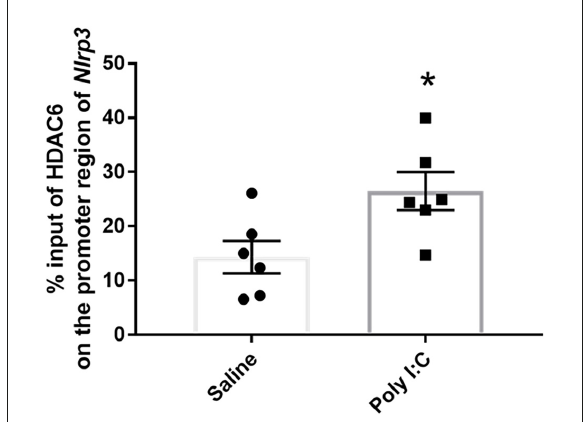
FIGURE5 Enrichment of Hdac6 on the promoter region of Nlrp3 . Data were presented as mean ± SEM ( n = 6/group). * p < 0.05, Poly I:C vs. Control.